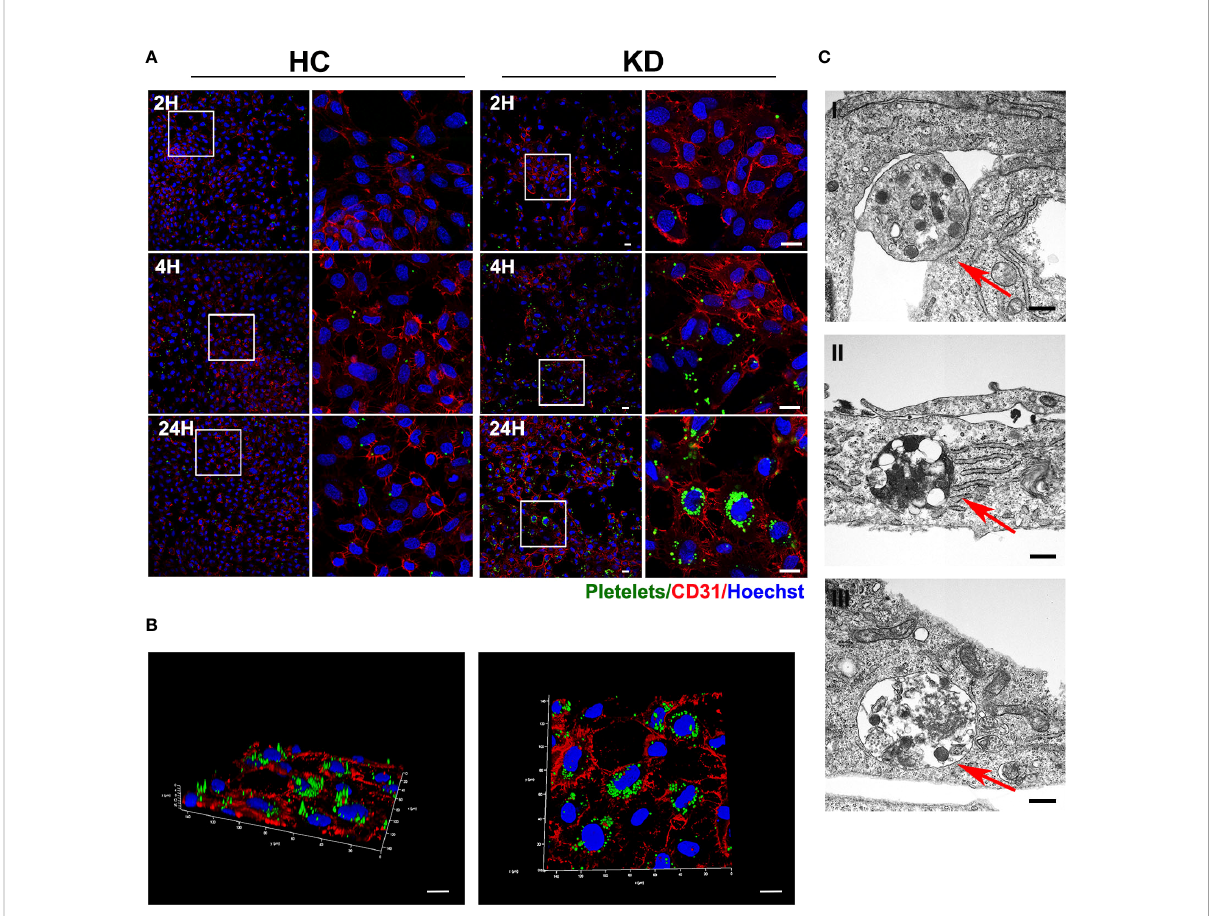
FIGURE 2 Activated KD platelets were internalized by HCAECs. (A) Representative immuno fl uorescence images of HCAECs co-cultured with CMFDA- labeled (green) HC or KD platelets for 2, 4, and 24 hours. Blue, Hoechst nuclear staining; red, CD31 in HCAECs (HC platelets: n = 6, KD platelets: n = 6). Scale bar: 20 m m. (B) Confocal three-dimensional reconstruction of Z-stack images of HCAECs co-cultured with CMFDA- labeled KD platelets (green) for 24 hours (KD platelets: n = 6). Scale bar: 20 m m. (C) Transmission electron microscopy of HCAECs co-cultured with KD platelets for 24h. (KD platelets: n = 3). I-III were images acquired in different fi elds of vision respectively. Red arrows indicated KD platelet internalized into HCAECs. Scale bar: